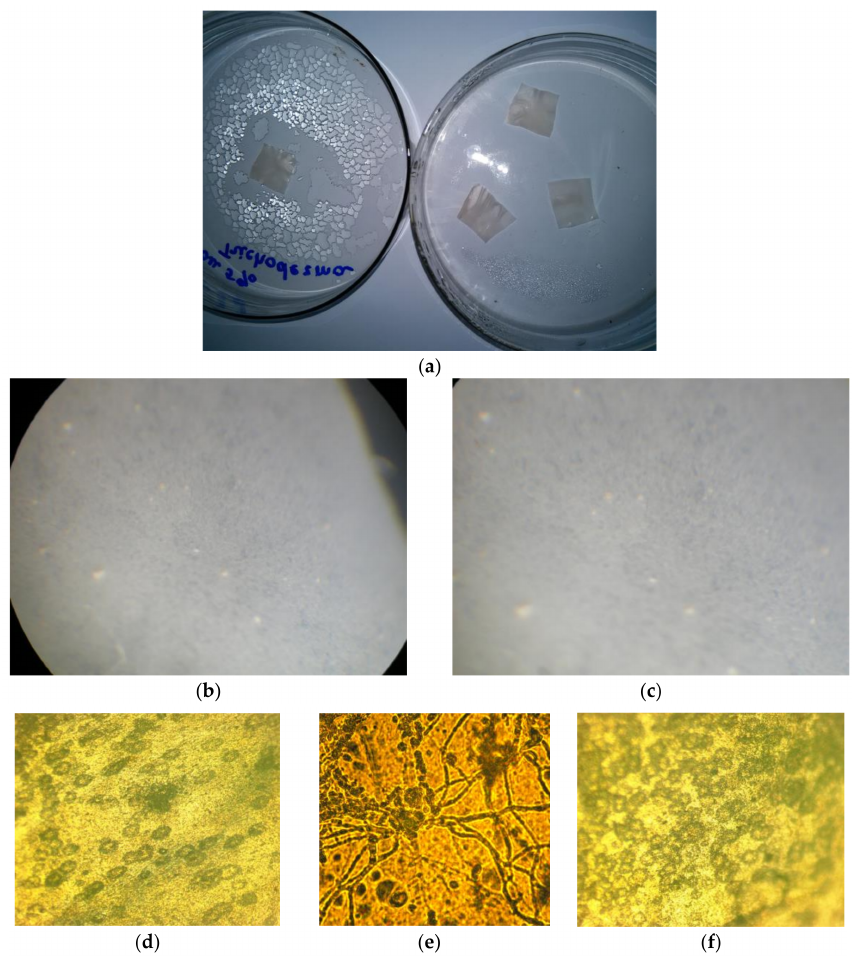
Figure 7. Evaluation of the fungal resistance of cellulose films with the wet-chamber method using the strain T. viride Pers. ex Fr. General view ( a ); scanning light microscopy, magnification of 200 × : ( b ) control (uninfected film), ( c ) test sample; light microscopy, 900 × magnification: ( d ) control (uninfected film), ( e ) control (infected cellulose film (without betulin)), ( f ) test